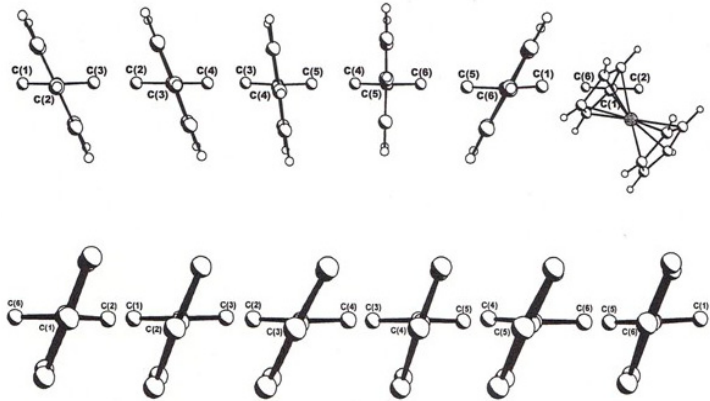
Figure 12. View along successive peripheral-ring–central-ring axes showing the sequence of peripheral phenyl torsion angles (top) in C 6 Ph 5 Fc and (bottom) in C 6 Ph 6 .